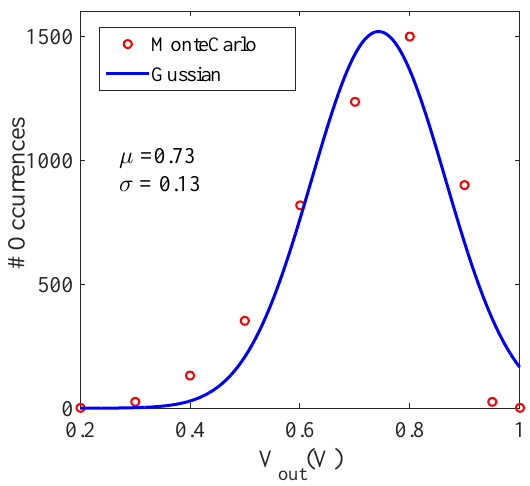
Figure 10. Monte Carlo and Gaussian distribution for output voltage of the proposed sensor.